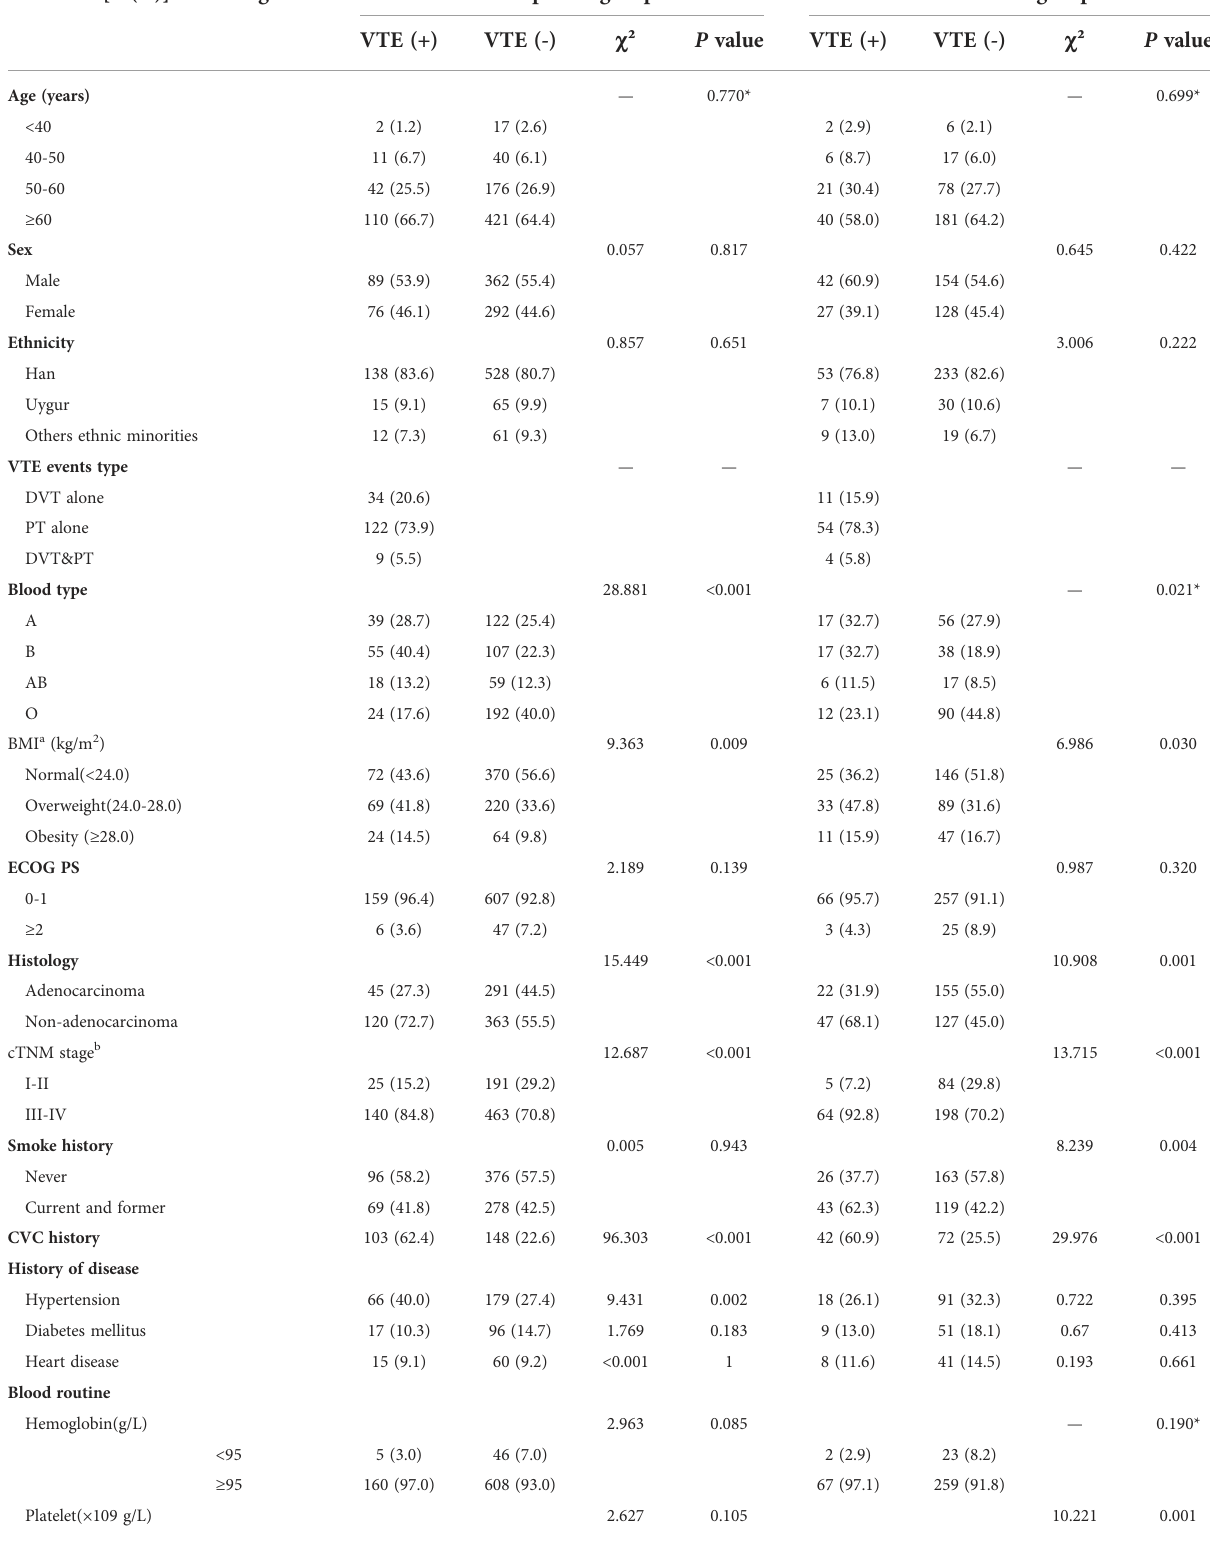
TABLE 1 Demographic and clinical characteristics of patients in derivation and validation